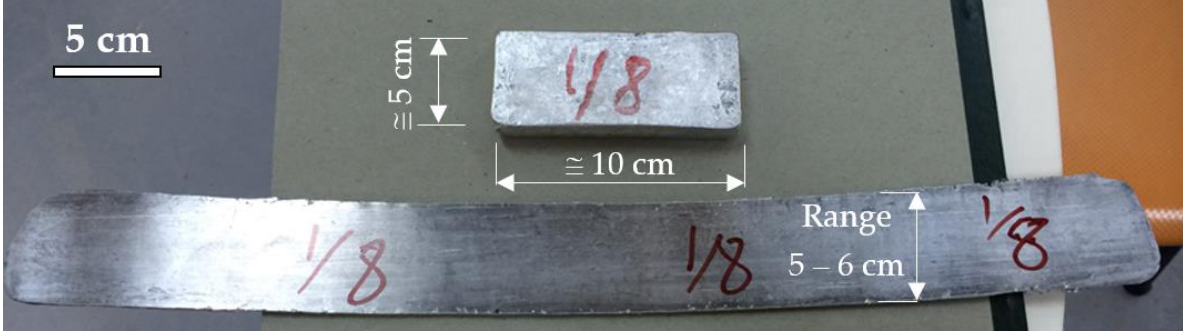
Figure 1. Alloys Before and after rolling.